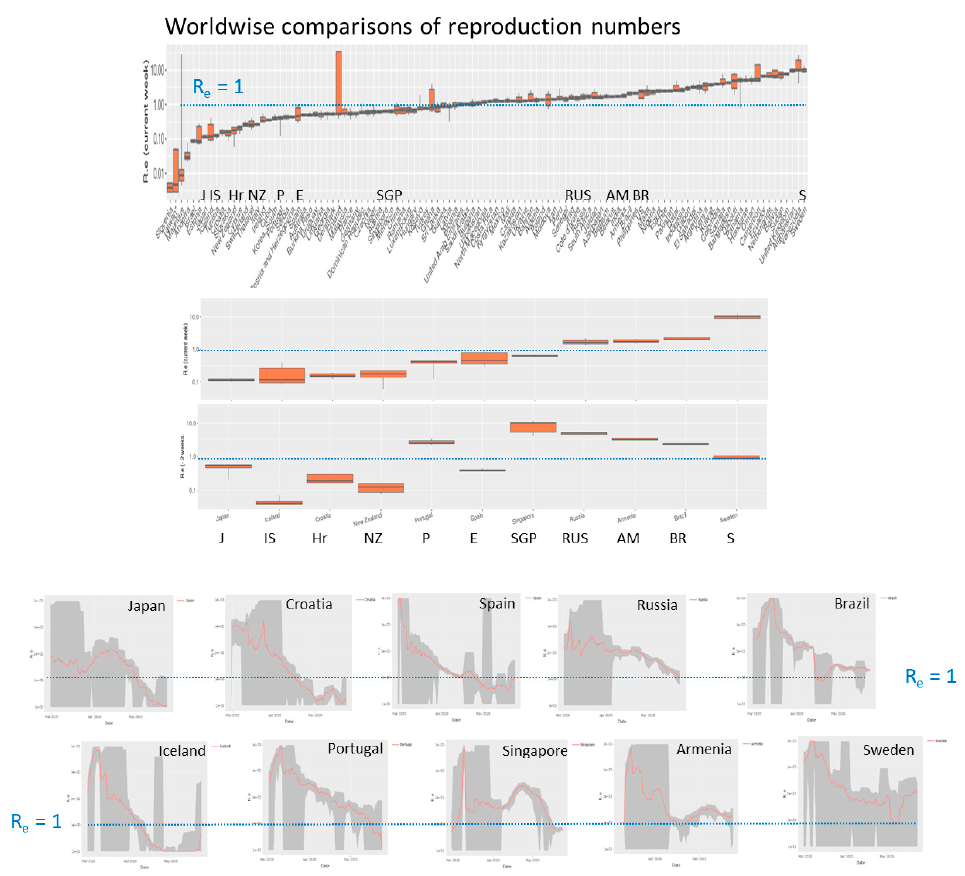
Figure 6. Effective reproduction numbers across the world. Ranked plot of current Re values across all countries studied indicate that less than half of them fall below the epidemic threshold of R e = 1 (horizontal dashed line). Time series for selected countries are shown as examples in the part below. They reveal sharp decays, virtually invariant and even increasing courses.